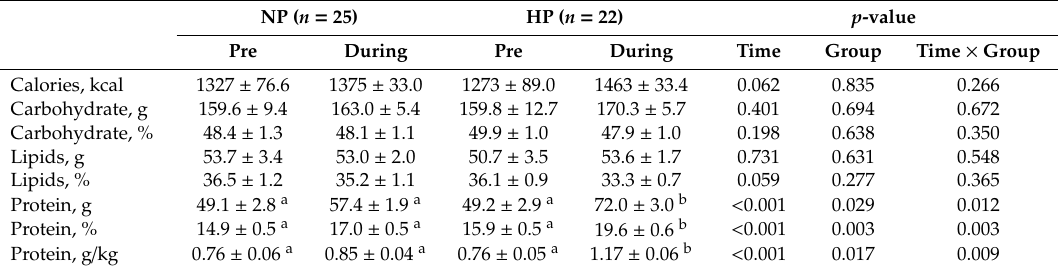
Table 2. Intake of calories and macronutrients according to moments and groups, with multiple imputation